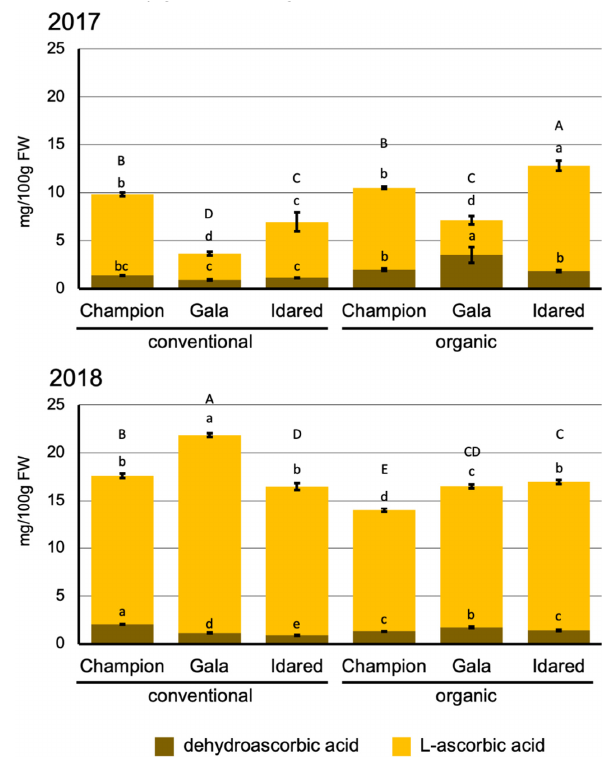
Figure 5. Concentrations (mean and SD) of vitamin C (dehydroascorbic and L-ascorbic acid) in Champion, Gala, and Idared apple fruits collected from organic and conventional orchards in 2017 and 2018 growing seasons. Within each season, bars marked with the same letters are not significantly different at p < 0.05 (Lowercase letters: for dehydroascorbic and L-ascorbic acid. Capital letters: for vitamin C (sum)).